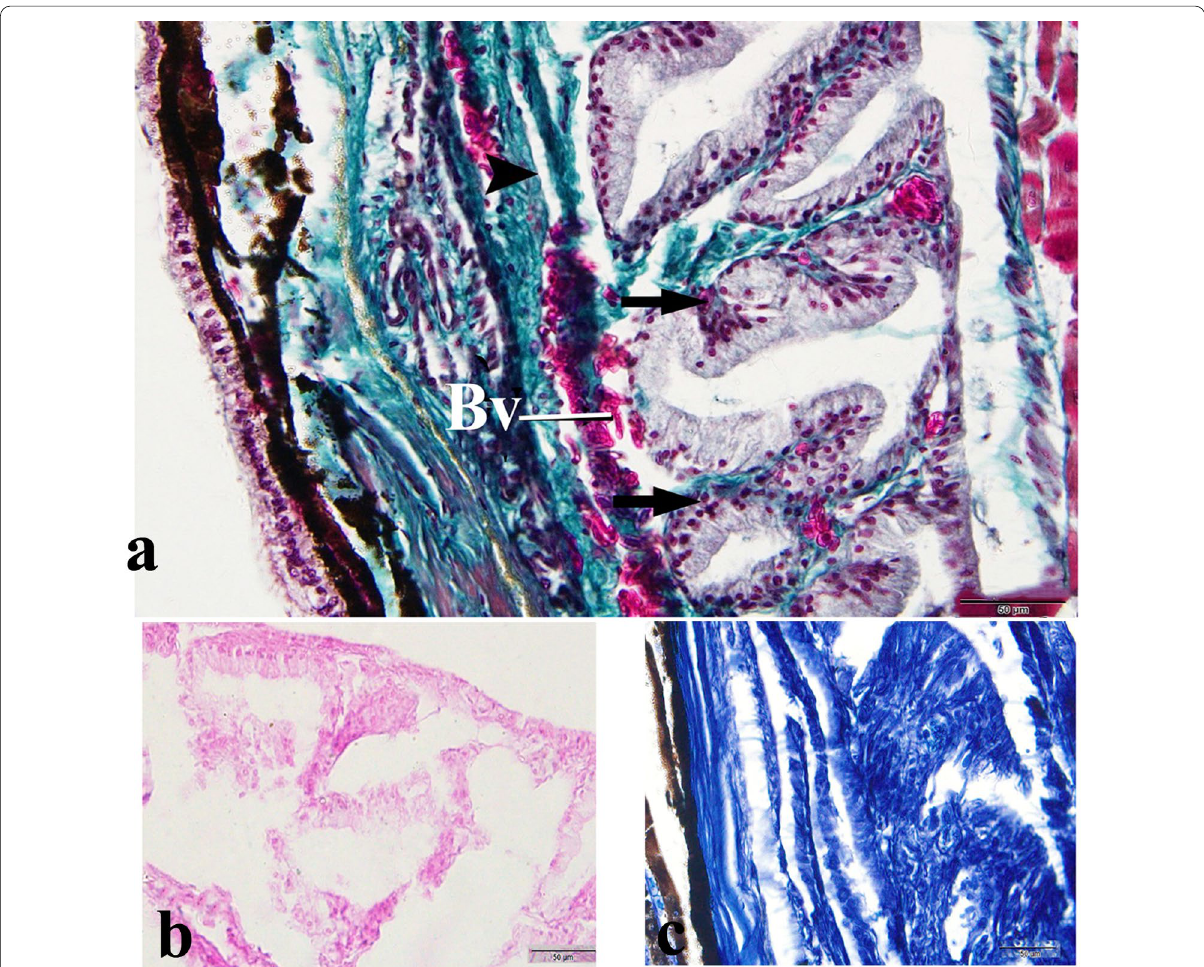
Fig. 7 A photomicrograph of a transverse section of the lacrimal gland of Egyptian agama, Trapelus mutabilis , showing a the lacrimal gland consists of simple tubulo‑acini of columnar cells (arrow) with narrow lumen and is surrounded by thick connective tissue capsule of strands of collagenous fibers (arrowhead) containing blood vessels (Bv) (Masson’s trichromic, 400), b glandular cells are weakly positive to the PAS reaction and c bluish × in color with alcian blue at pH 2.5 ( ×